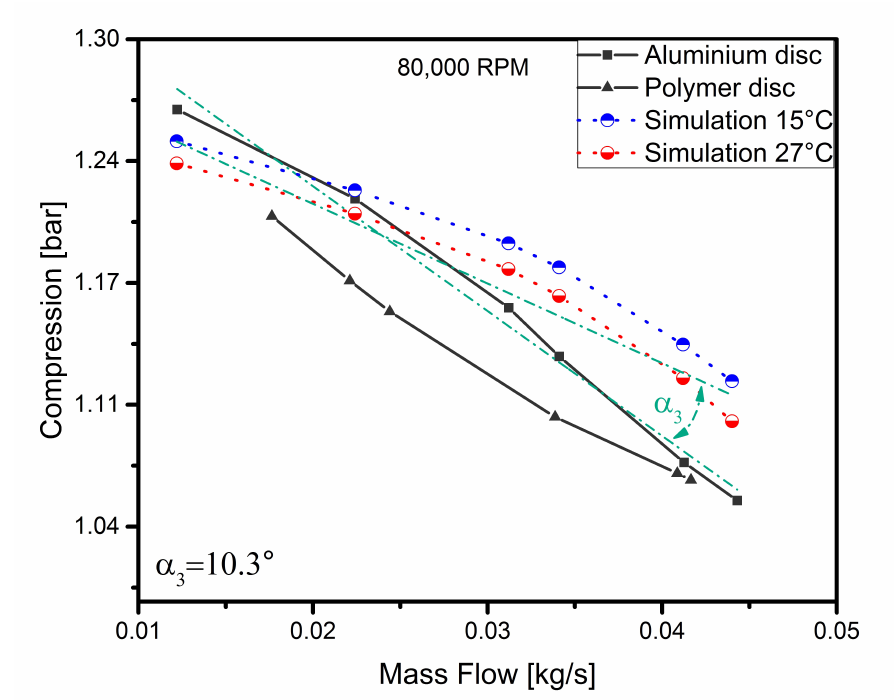
Figure 7. Simulation vs. experimental results for a speed of 80,000